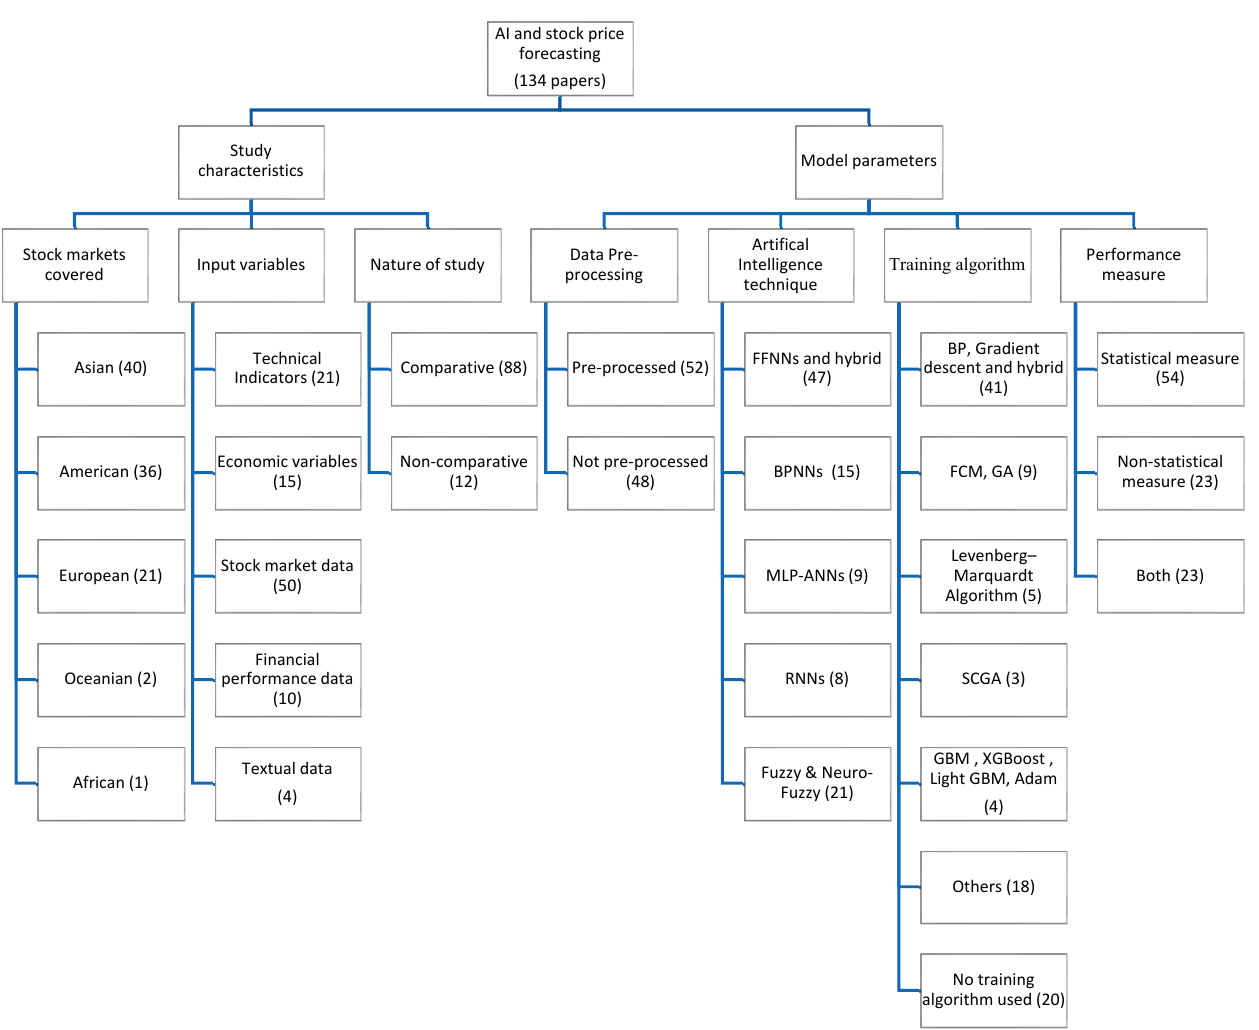
Figure 1. Organizing Framework. (Note: The percentage of papers falling into each category is mentioned in each box.).